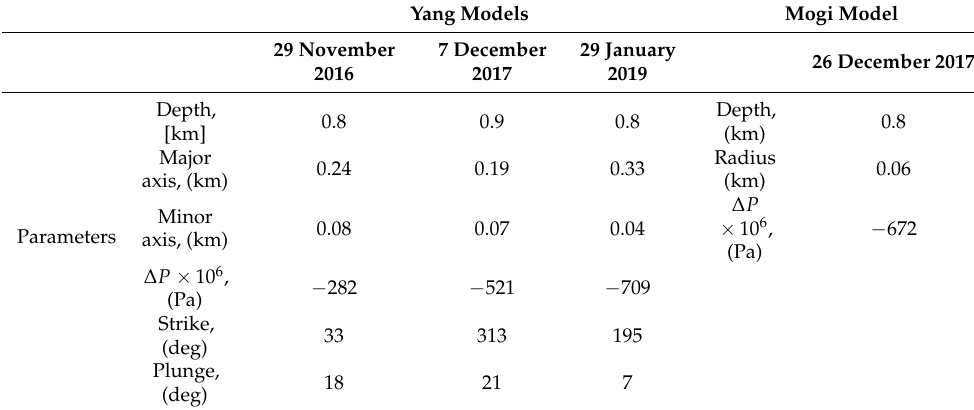
Table 5. Source parameters determined from DInSAR